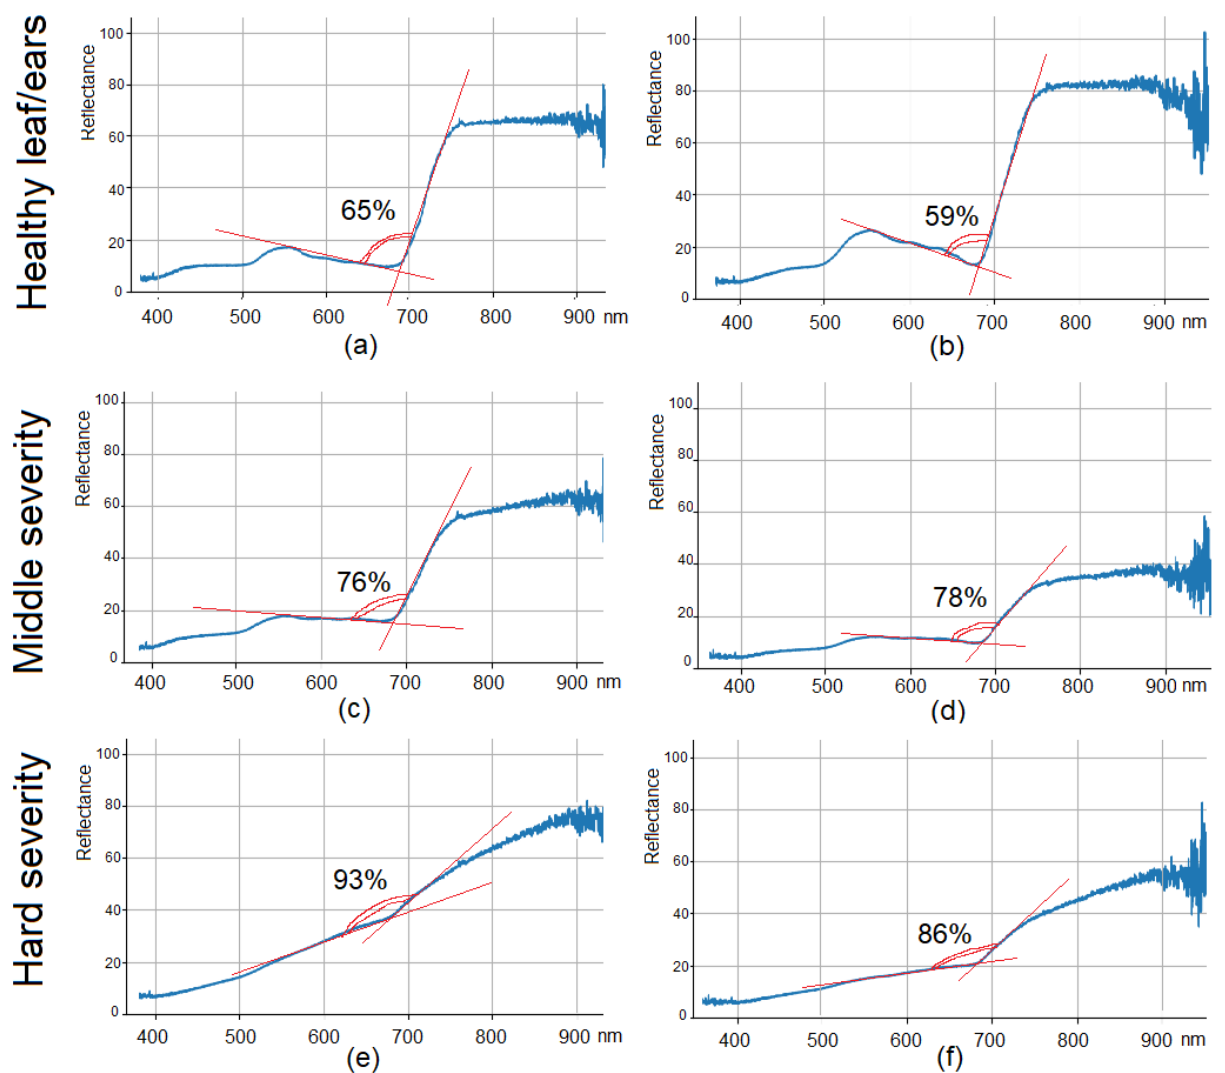
Figure 7. Hyperspectral curves of reflectance of leaves ( a , c , e ) and ears ( b , d , f )—means of healthy, medium-damaged and severely damaged leaves and ears, respectively, and values of the angle (%) between the branches of the graph.